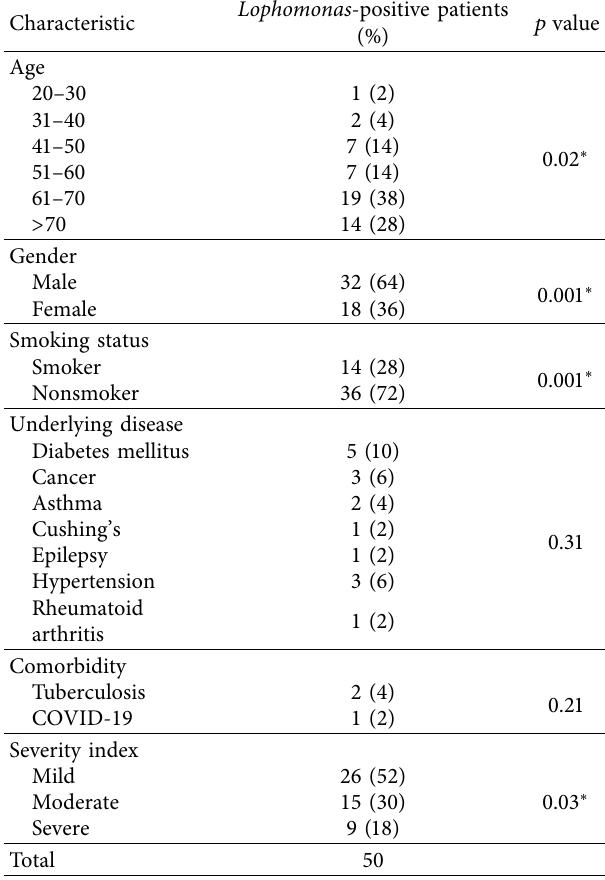
Table 2: Demographic findings and characteristics of patients with Lophomonas infection referred to the INRCL according to the severity